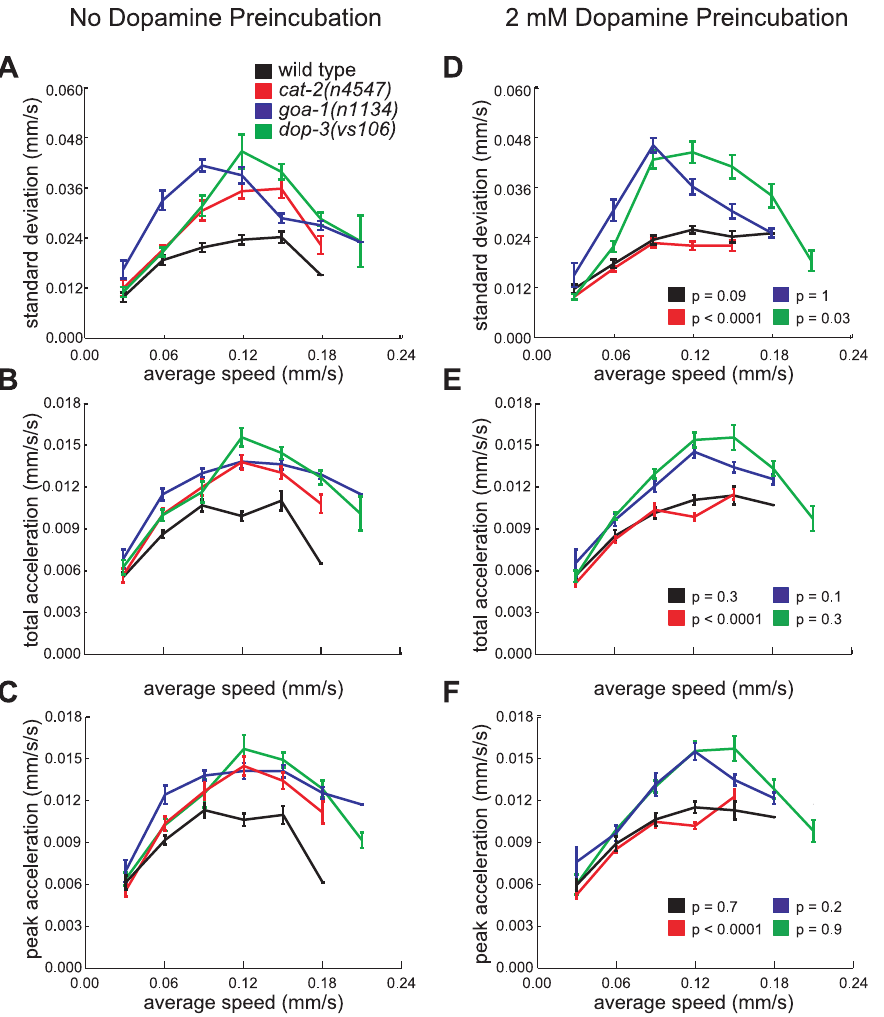
Figure 6. Pre-treatment with exogenous dopamine restores normal locomotion to cat-2 but not dop-3 or goa-1 mutants. The average (A) standard deviations of speed measurements within individual tracks, (B) magnitude (root mean square) of accelerations, and (C) acceleration peaks for animals on a bacterial lawn. The average (D) standard deviations of speed measurements within individual tracks, (E) magnitude (root mean square) of accelerations, and (F) acceleration peaks for DA pre-treated animals on a bacterial lawn. p-values for differences between dopamine- treated and untreated animals of the same genotype were calculated using two-way ANOVA. Tracks were first grouped by average speed. Each bin is 0.03 mm/sec wide. Error bars, SEMs. (wild-type n=120 no dopamine, 131 DA pretreated animal tracks; cat-2(n4547) n=107, 139; dop-3(vs106) n=122, 128; goa-1(n1134) n=162, 150; all tracks . 30 sec)